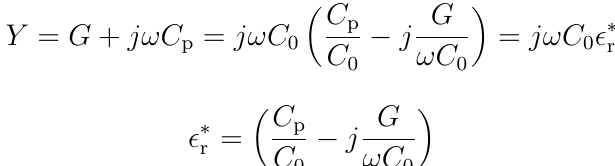
and dielectric loss ( G ) measured p and G were measured by impedance meter at p